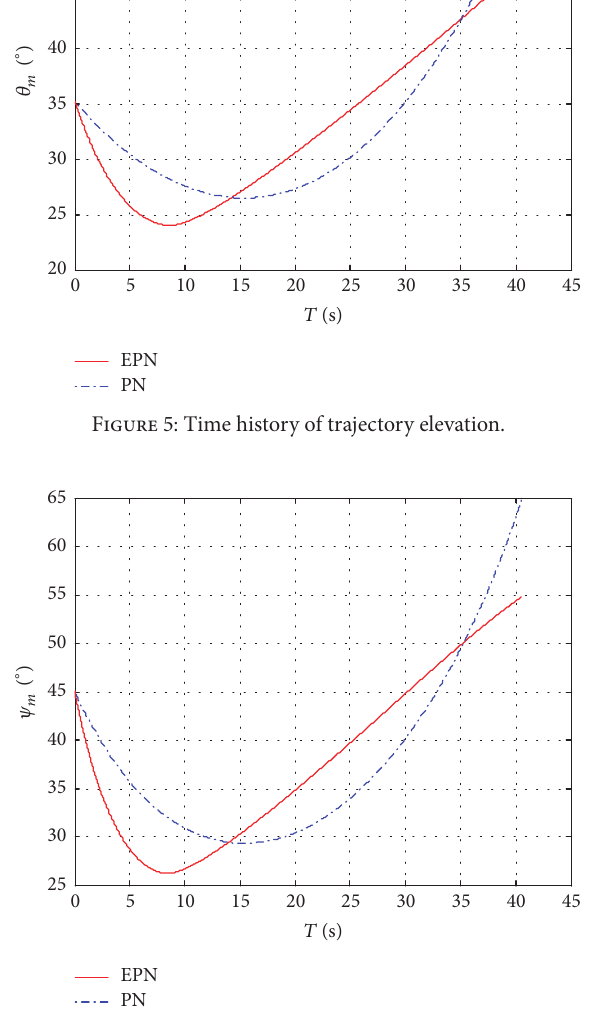
Figure 8: Time history of lateral